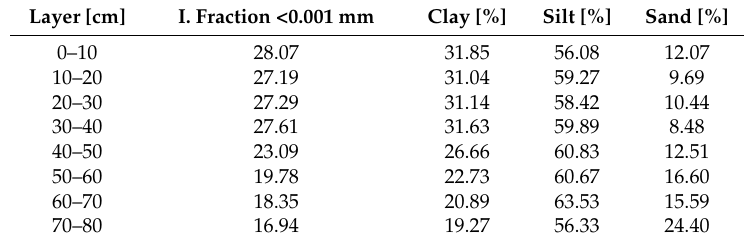
Table 2. Texture characteristics of studied soil profiles in Michalovce. Analogously, all examined profiles were characterized.